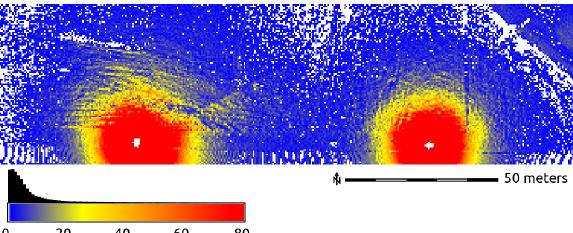
Figure 3: The number of points per cell for point cloud obtained using ground-based lidar (raster resolution 0.5 m). Note that the color table uses red color for values from 80 up to the maximum which is 18 thousand points per cell.